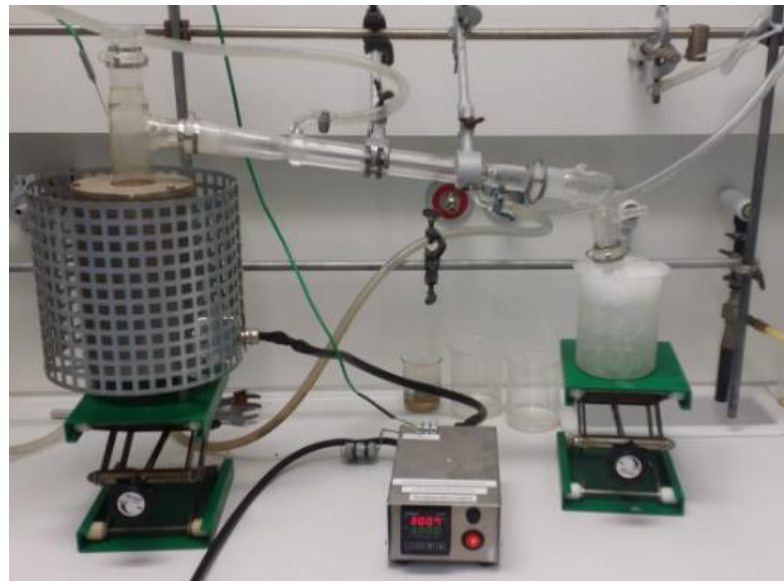
Figure 7. Batch Reactor Assembly.